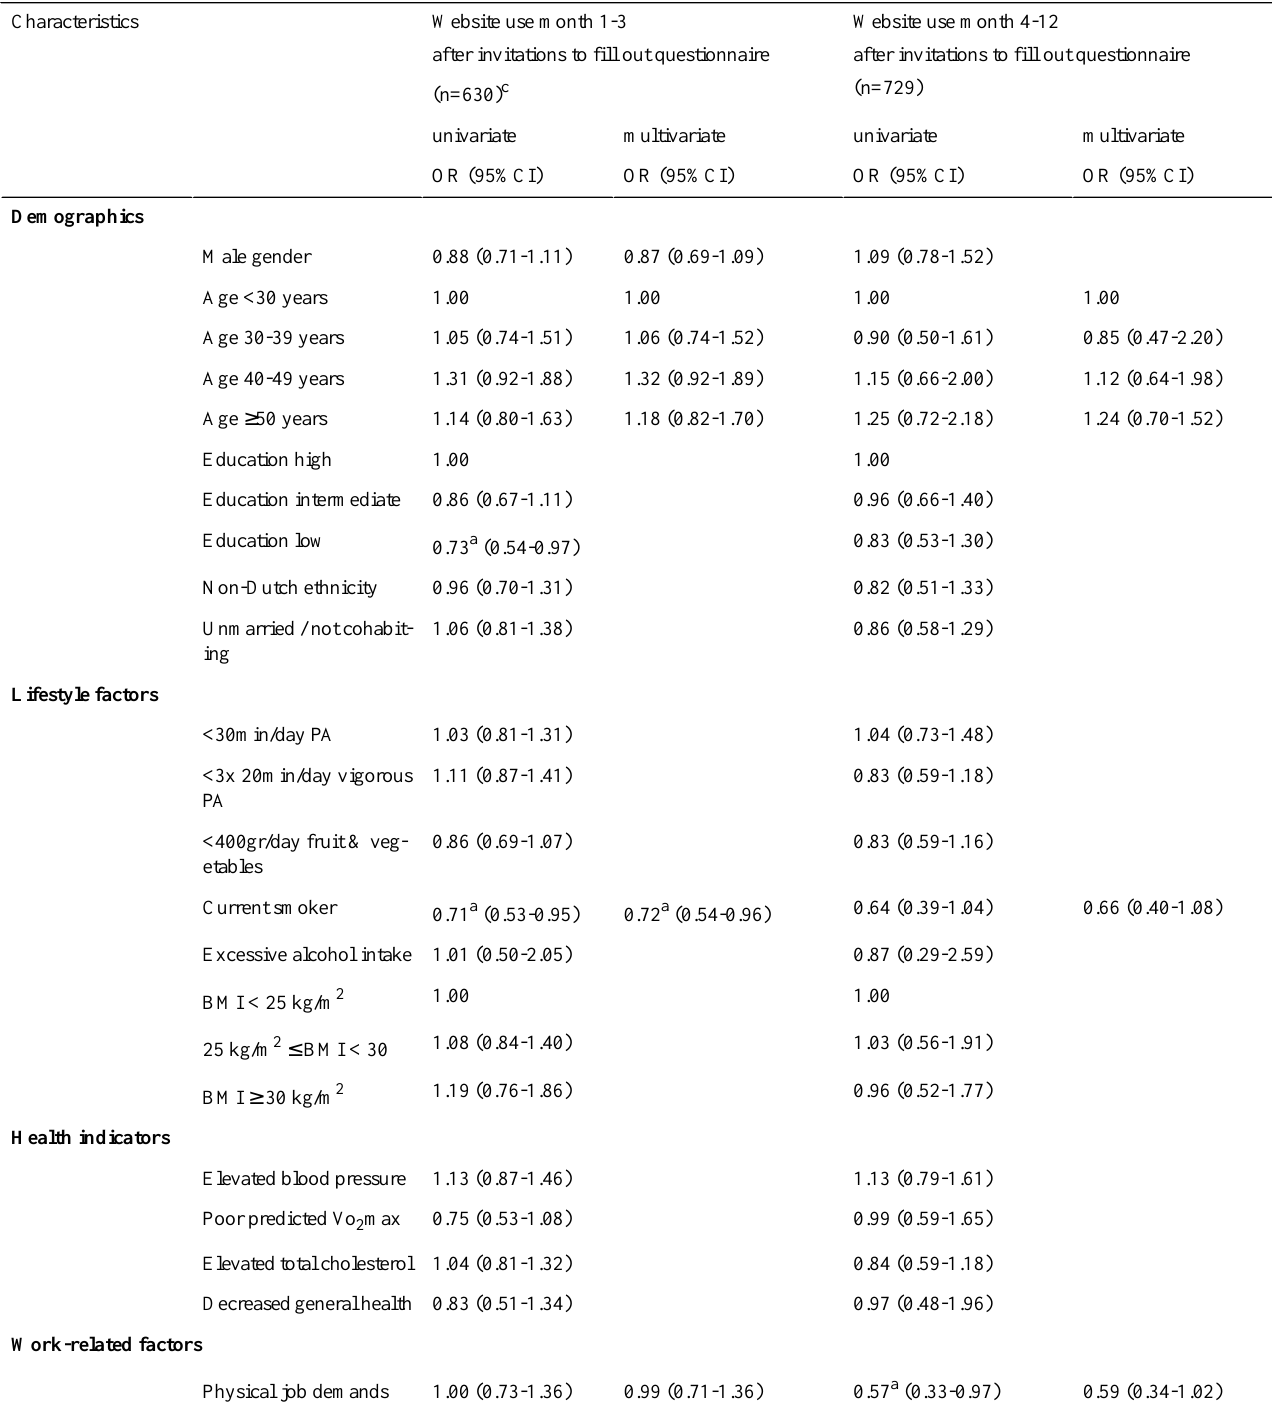
Table 4. Determinants of website use of a workplace health promotion